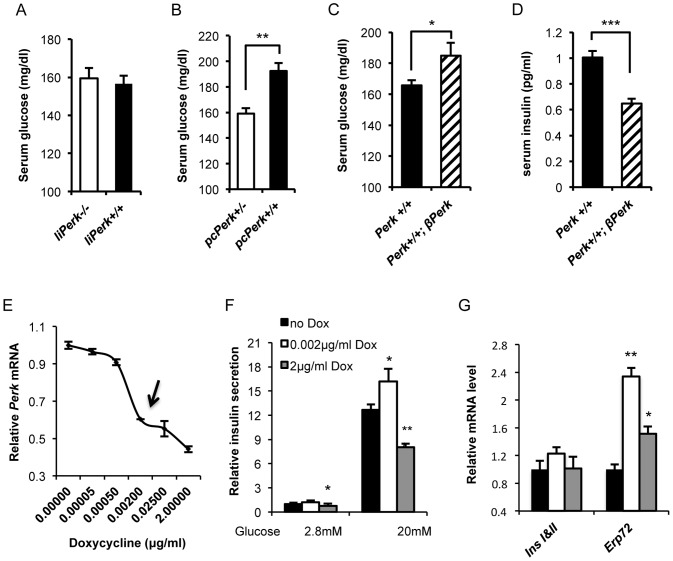

Perk gene dosage specifically in the β-cells regulates glucose homeostasis and insulin secretion.A. Random fed serum glucose of liver-specific Perk KO mice (liPerk−/−) or liPerk+/+ at 70 days old. (n = 8, 8. A trend towards high blood glucose was seen in liPerk−/− mice but was not significantly different from wild-type control mice.). B. Random fed serum glucose of pancreatic-specific Perk+/− (pcPerk+/−) or pcPerk+/+ at age of P17-P35. Mice are in C57B/L6 background (n for pcPerk+/−, pcPerk+/+  = 18, 43. **P<0.01). C. Random fed serum glucose of Perk+/+;βPerk mice or wild-type littermates at age of P21-P38. Mice are in C57B/L6 background (n for Perk+/+, Perk+/+;βPerk  = 63, 36. *P<0.05). D. Random fed serum insulin of Perk+/+;βPerk mice or wild-type littermates at age of P27-P64. Serum insulin of each mouse was normalized to the average of wild-type littermates. Mice are in C57B/L6 background (n for Perk+/+, Perk+/+;βPerk  = 44, 16. ***P<0.001). E. Perk mRNA measurement in INS1 832/13 shPerk β-cells pre-treated with indicated concentration of doxycycline for 24 hours. Perk mRNA level was normalized to the level of non-doxycycline control (n = 4 per dosage point). F. Insulin secretion in response to 2.8 mM or 20 mM glucose in INS1 832/13 shPerk β-cells pre-treated with indicated concentration of doxycycline for 24 hours. Insulin secretion was normalized to total protein and expressed as fold increase in relative to basal insulin secretion (2.8 mM glucose) of non-doxycycline control. Shown are means ± SEM. (n≥4 per treatment. Statistical significance was determined by comparing to no-doxycycline control. * P<0.05, *** P<0.001). G. Gene expression measurement in INS1 832/13 shPerk β-cells pre-treated with indicated concentration of doxycycline for 24 hours. The mRNA level of each gene was normalized to the level of no-doxycycline control (n = 4 per dosage point. Statistical significance was determined by comparing to no-doxycycline control. *P<0.05, **P<0.01).